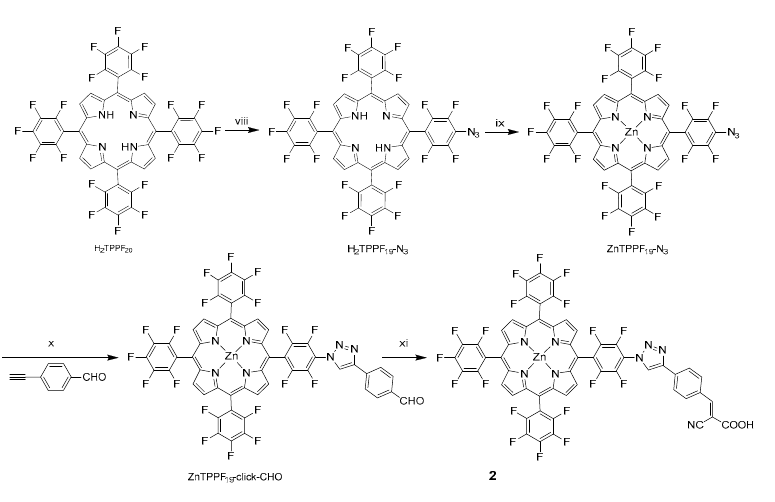
Scheme 2. Synthesis of dye 2.